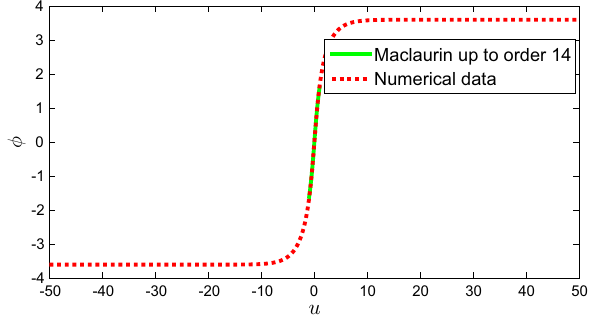
Fig. 4 Plotof φ( u ) usingtheMaclaurinseriesobtainedfromEq.(A14) and its numerical solution for the parameter values c = 0 . 5 and s = 1